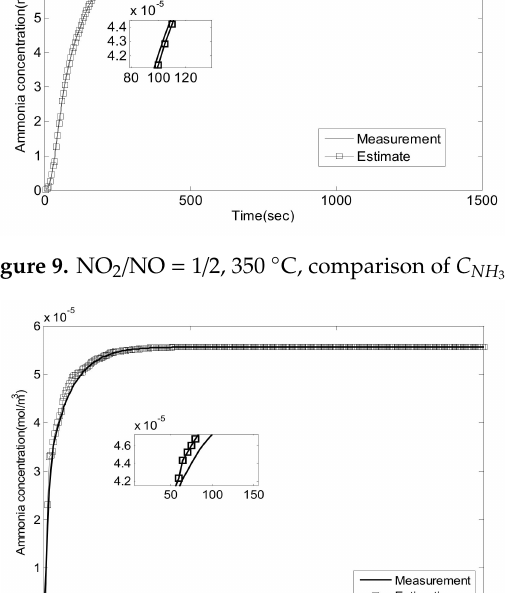
Figure 10. NO 2 / NO = 1 / 2, 400 ◦ C, comparison of C NH